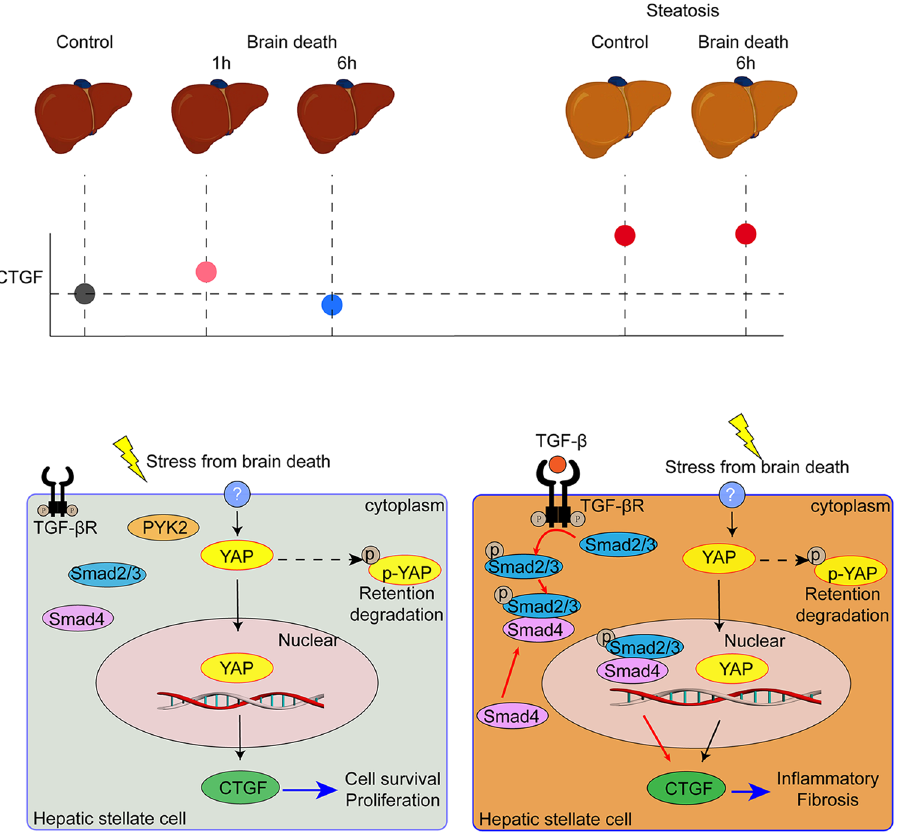
Figure 7. CTGF expression in hepatic stellate cells and its regulation in the non-steatotic liver and the non- alcoholic steatotic liver after brain